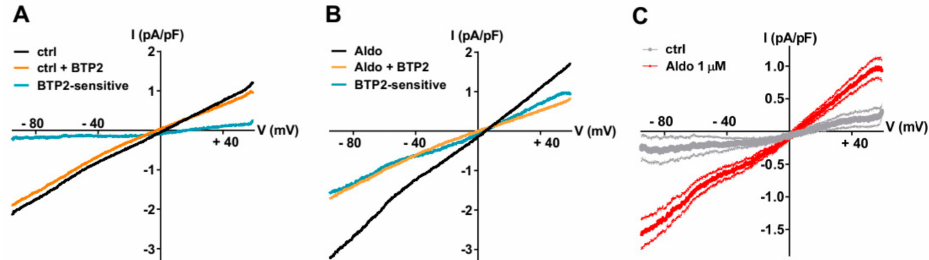
Figure 2. A 24-h aldosterone treatment increases SOC currents ( I SOC ) in ARVMs. ( A , B ) Representative current–voltage (I–V) relationships elicited by ramp voltage-clamp protocol in ARVMs incubated for 24 h without ( A ) or with aldosterone 1 µ M ( B ), following SR Ca 2 + depletion (black traces) and then in the presence of 5 µ M BTP2 (orange traces). BTP2-sensitive (blue traces) represents the di ff erence current. ( C ) Scatter plots of mean ± SEM of the BTP2-sensitive I–V relationships recorded in ARVMs incubated for 24 h without (gray trace, − 0.19 ± 0.19 pA / pF at − 90 mV and 0.30 ± 0.17 pA / pF at + 60 mV, n = 7) or with Aldo 1 µ M (red trace, − 1.51 ± 0.20 pA / pF at − 90 mV ( p < 0.01) and 0.90 ± 0.15 pA / pF at + 60 mV ( p < 0.05), n = 9) from three cell isolations. Statistical significance was evaluated using Student’s t -test.